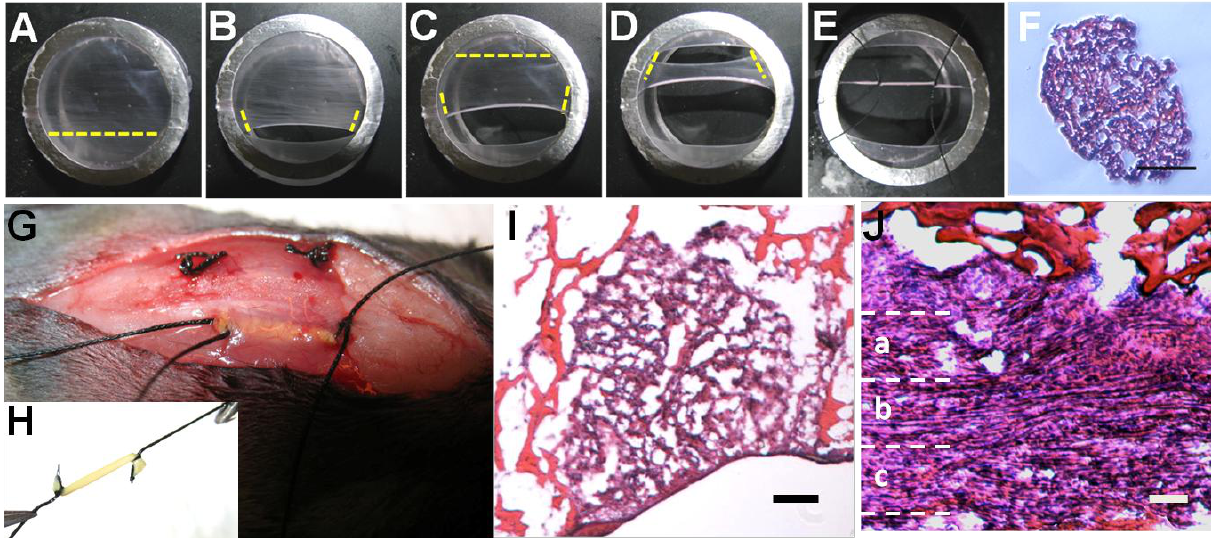
Figure 6. Aligned nanofiber/cell sheets self-assembled into rod-like structures when they were cut in a pattern ( A – E ). H&E staining of the cross-section of such a structure details its microstructure ( F ). A thick, aligned nanofiber-cell cable graft ( H ) was implanted in the intravertebral muscle ( G ) of a mouse. H&E staining of a retrieved cable graft at one day post-implantation in the cross-section ( I ) and in the graft long axis ( J ). Alignment along the graft long axis was quantified using the ImageJ FibrilTool [26] for different regions of the implant. Anisotropy scores were 0.24, 0.42 and 0.34 for regions a, b and c, respectively. Scale bar = 100